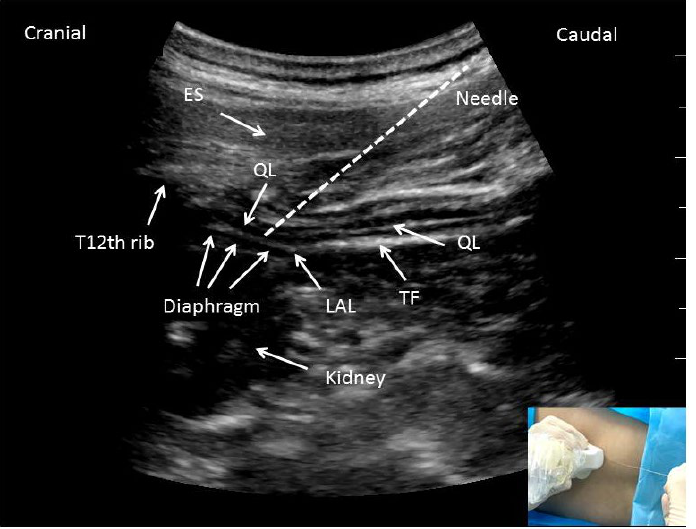
Figure 3. Parasagittal anterior QLB-LSAL under ultrasound guidance. QLB-LSAL, quadratus lum- borum block at the lateral supra-arcuate ligament; QL, quadratus lumborum; ES, erector spinae; LAL, lateral arcuate ligament; TF, tranversalis